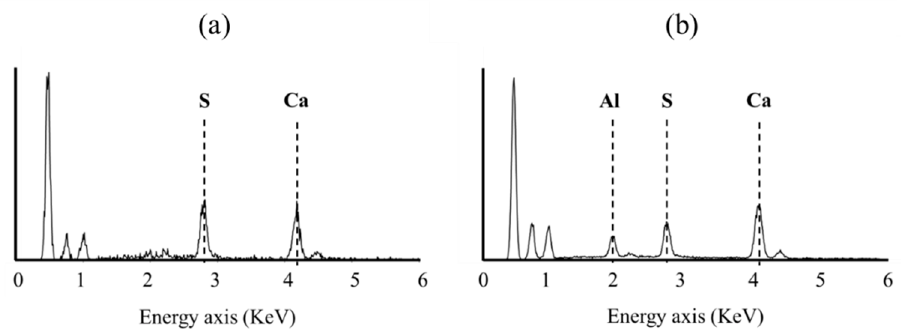
Figure 1. Spectrum of reference to detect gypsum ( a ) and ettringite ( b ) by SEM-EDS.